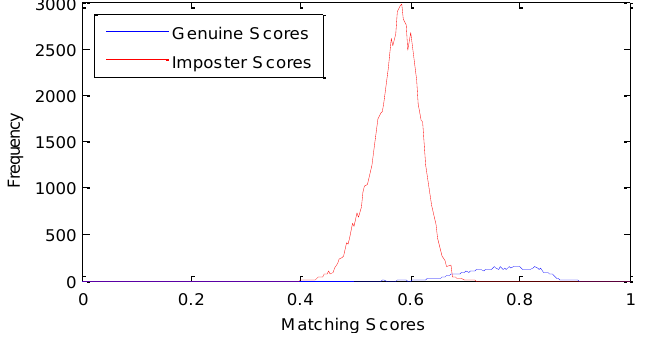
Figure 7. Genuine and imposter matching score distributions by LBP.